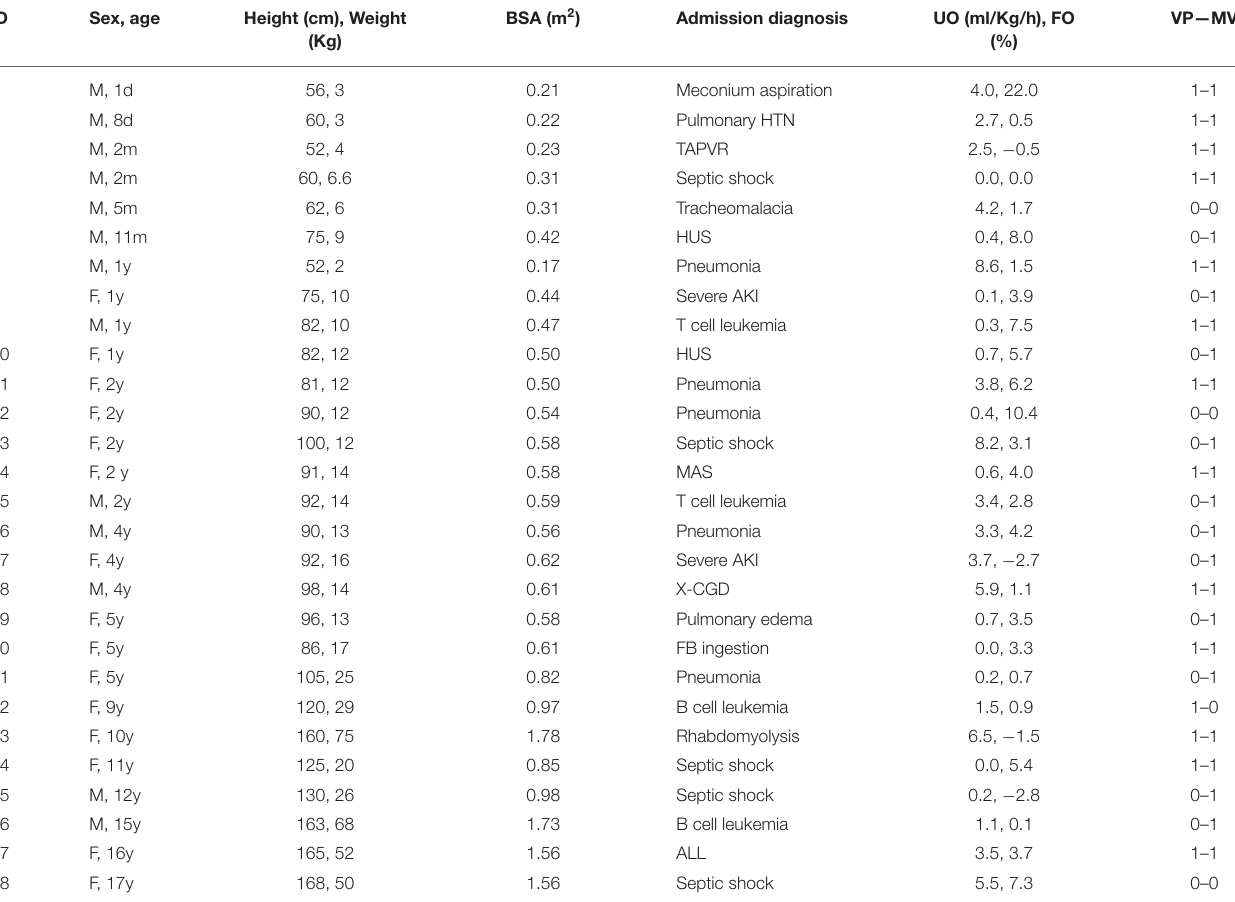
TABLE 1 | Demographic and clinical characteristics at pediatric intensive care unit